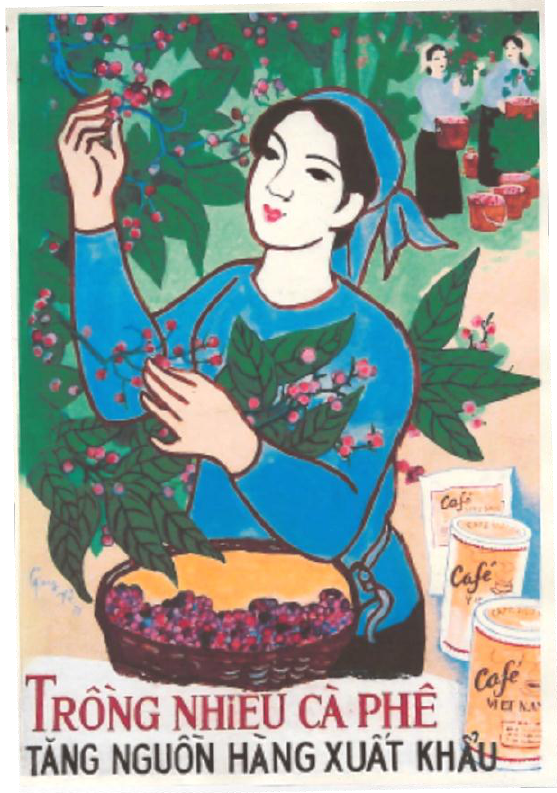
Figure 2. “Grow coffee to increase the number of products for exportation”—propaganda poster for promoting coffee production in Vietnam.